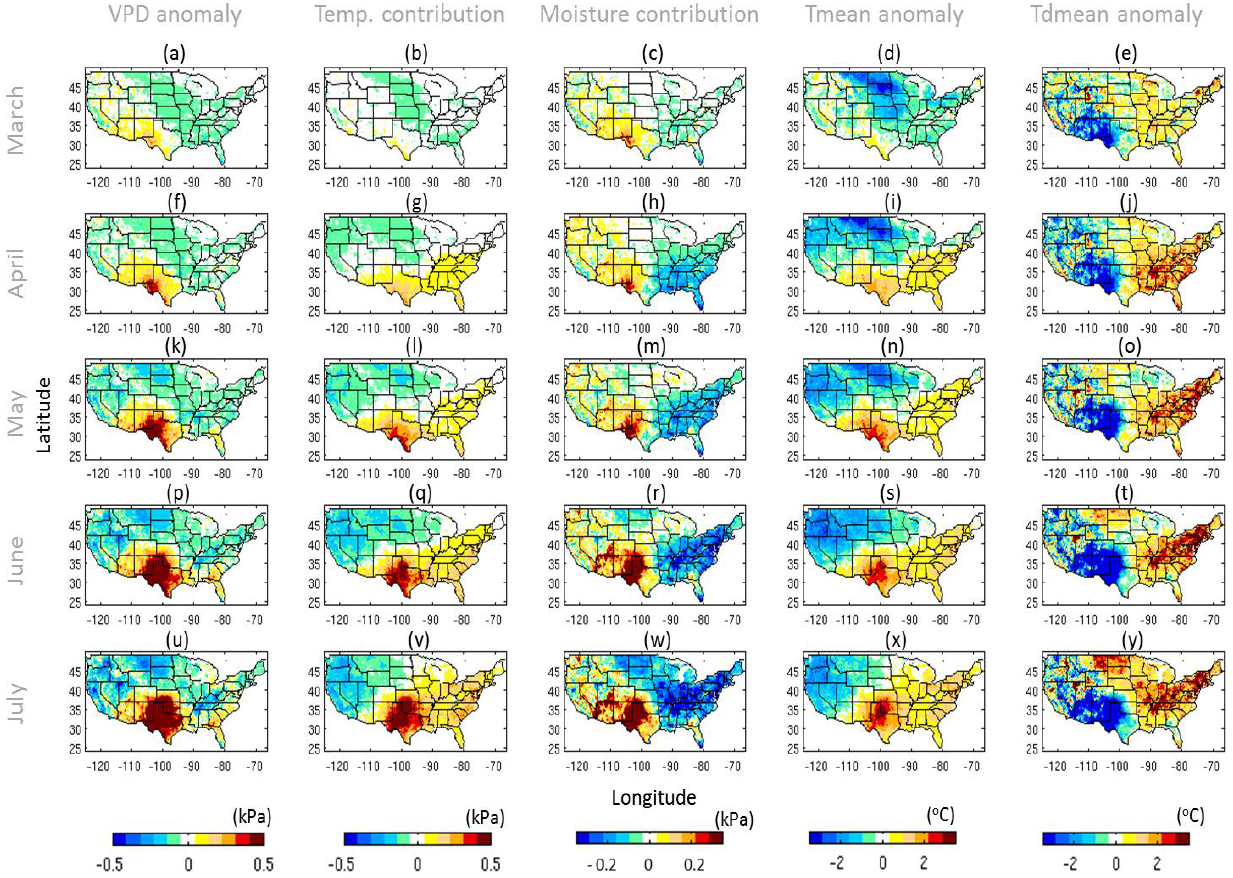
Figure 4. Development of 2011 Texas and southern US drought and the contribution of temperature and humidity in forming high evapotranspiration demand inferred by VPD. From left to right columns represent 3 month ( a ) VPD anomaly (kPa); ( b ) temperature contribution to evapotranspiration demand; ( c ) humidity contribution to 2011 evapotranspirational demand; ( d ) Tmean anomaly; and ( e ) Tdmean anomaly. Similar